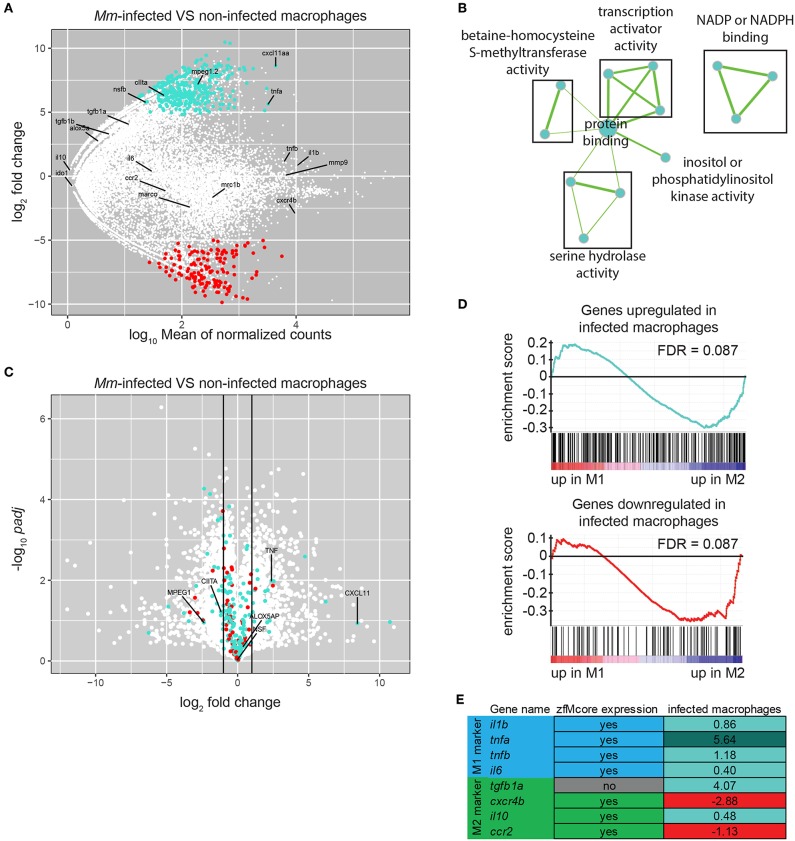
M. marinum infected macrophages exhibit a change in gene expression toward M1-polarization. (A) MA-plot showing the fold change (log2-transformed) between gene expression in Mm-infected and non-infected mpeg1:gfp positive cells from a 6 dpf embryos 5 days after injection of 100–125 cfu of Mycobacterium marinum M strain containing pSMT3-mCherry as a function of the normalized average count between the two conditions (log10-transformed) as calculated with DEseq2. Turquoise: log2FC ≥ 1 and P-adj < 0.05, red: log2FC ≤ −1, and P-adj < 0.05. (B) Network visualization of GO enrichment analysis of human homologs of up-regulated genes in infected macrophages compared with uninfected macrophages from infected larvae using BiNGO and EnrichmentMap. Network legend is similar to Figure 1C. (C) Volcano plot showing the P-value (–log10-transformed) as a function of the fold-change (log2-transformed) between human M1 and M2 gene expression level of the gene set from Beyer et al. (40). Turquoise and Red dots are genes with a zebrafish homolog respectively up- and down-regulated in the infected macrophages compared with the non-infected macrophages from M. marinum infected larvae. (D) Gene Set Enrichment Analysis (GSEA) plots of gene expression changes in human M1 in vitro polarized macrophages compared to human M2 in vitro polarized macrophages from Beyer et al. (40). Gene sets used for the analyses are human homologs of genes found up-regulated (log2FC ≥ 1 and P-adj < 0.05) (top) and down-regulated (log2FC ≤ −1 and P-adj < 0.05) (lower) in macrophages upon Mm infection as described in (A). (E) Table presenting the zebrafish genes expressed in M1 and M2 macrophages studied in Nguyen-Chi et al. (16). First column indicates their presence in our zfM core dataset. Second column indicates their enrichment (log2Fold Change) in Mm-infected macrophages compared to uninfected macrophages. Turquoise: log2FC ≥ 1 and P-adj < 0.05, light turquoise: log2FC ≥ 0, red: log2FC ≤ 0.